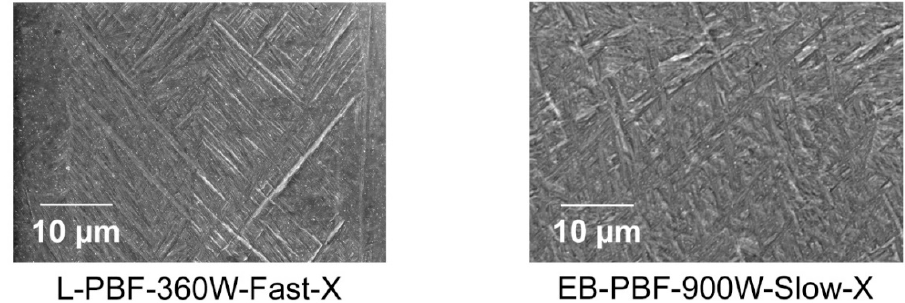
9 of 18 Figure 7. Crystallite size of the α or α ’ phase versus the β quantity scatter plot for all L-PBF parts. A correlation between the crystallite size and the β quantity is seen. 3.2. Microstructure The representative microstructures of the L-PBF and EB-PBF-made parts (L-PBF-360W- Fast-X and EB-PBF-900W-Slow-X) are shown in Figure 8. The α and α ’ laths typical for PBF-